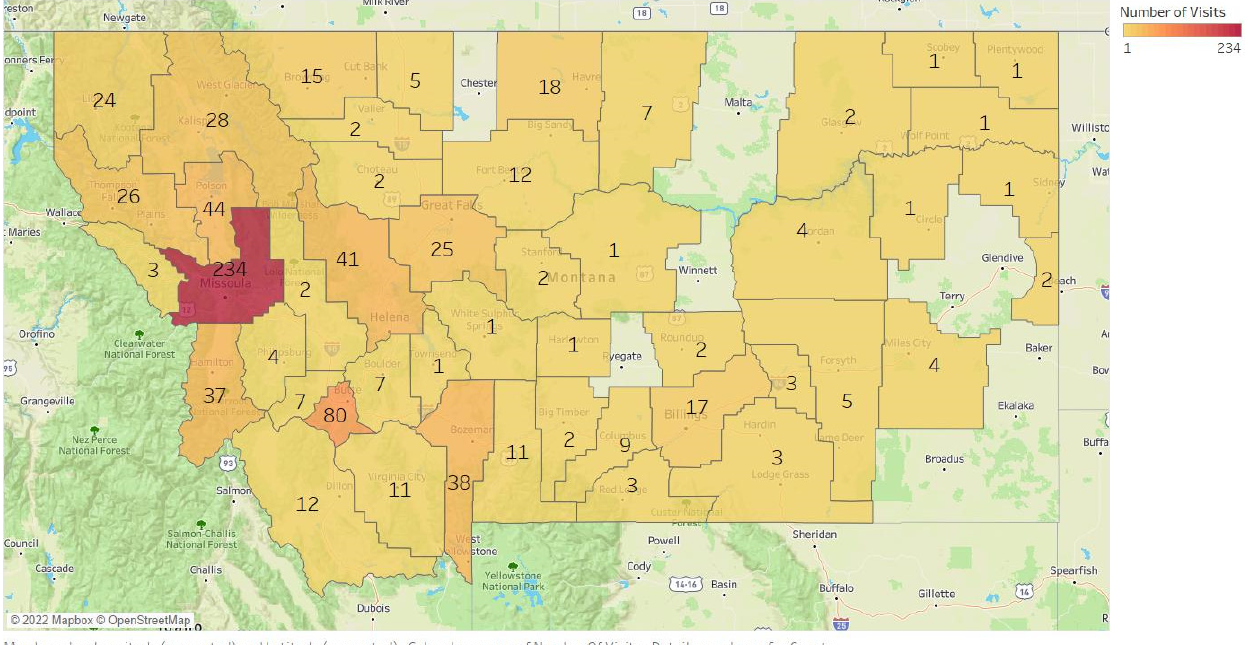
Figure 1. The numbers in each county represent how many IPHARM events occurredfrom 2003–2021 per county across Montana.